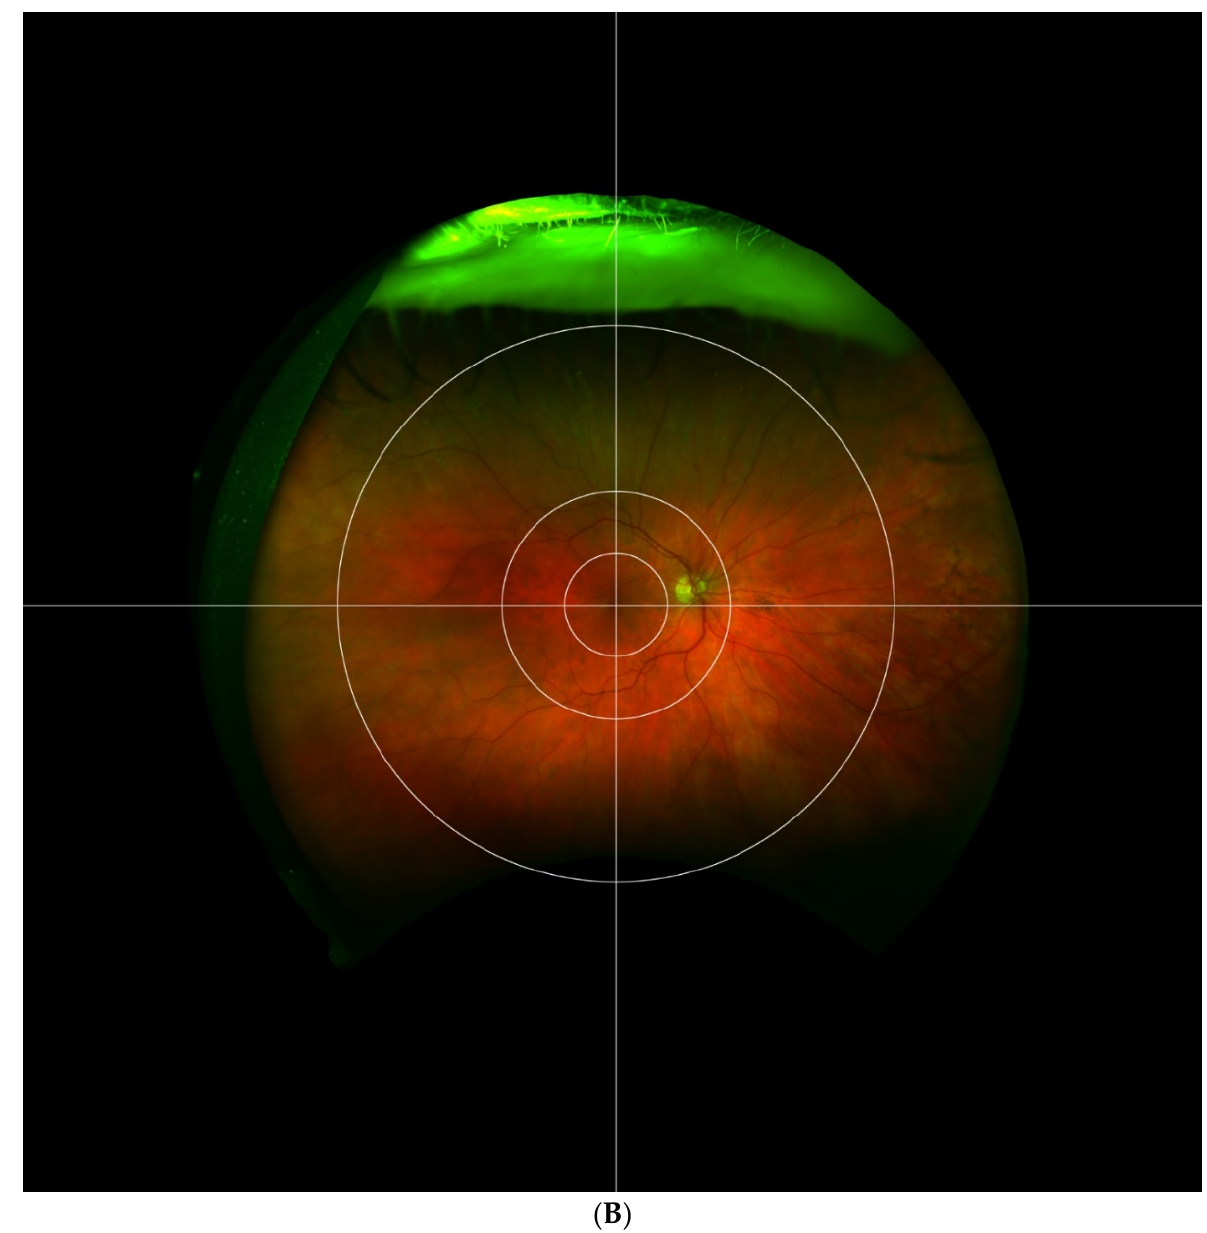
Figure 2. The Boston grid is depicted superimposed on fundus images of right ( A ) and left ( B ) eyes. The grid is composed of 3 concentric circles centered on the fovea, separating the retina into central, perimacular, mid-peripheral, and far-peripheral areas. Horizontal and vertical lines further separate the retina into superior, inferior, temporal, and nasal quadrants, producing a total of 12 zones.